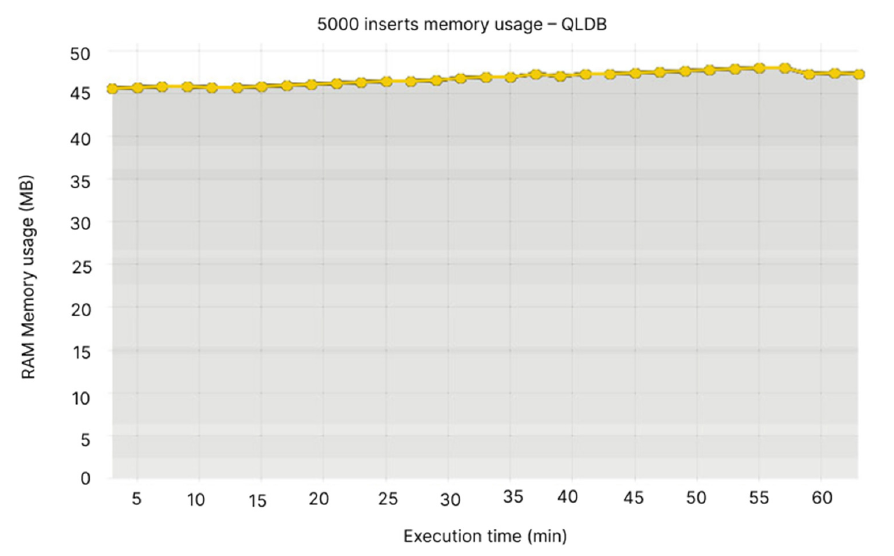
Figure 13. 5000 inserts memory usage—QLDB.